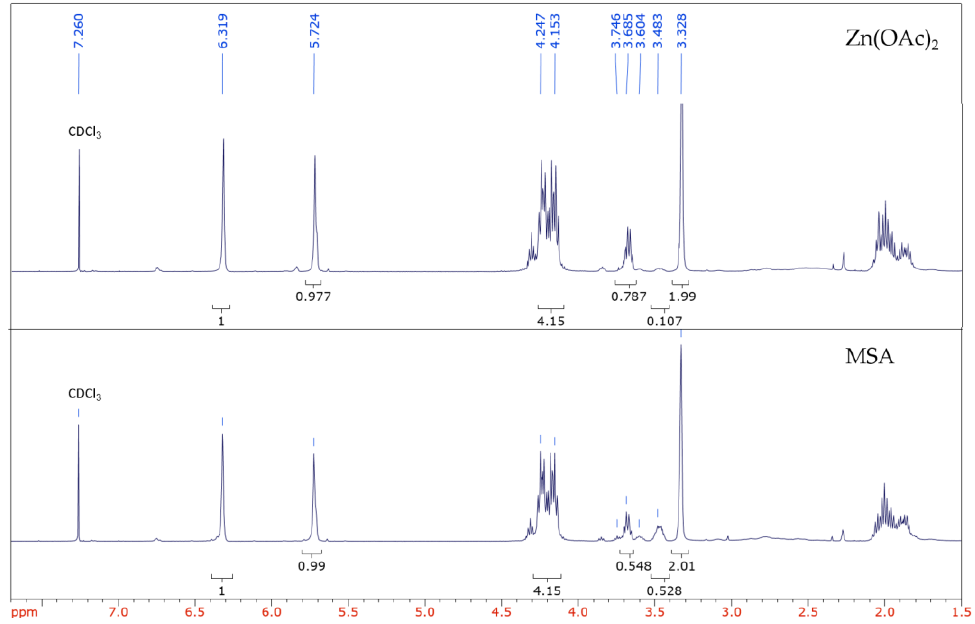
Figure 5. 1 H NMR of the polycondensation reaction with MSA ( below ) and Zn (OAc) 2 ( top ) in CDCl 3 .